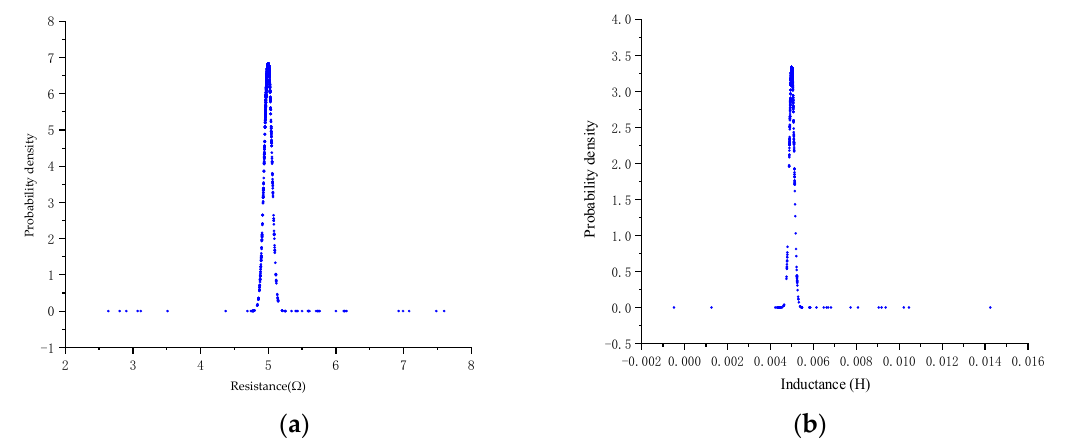
Figure 11. Load parameter identification with background harmonic: ( a ) resistance; ( b ) inductance.